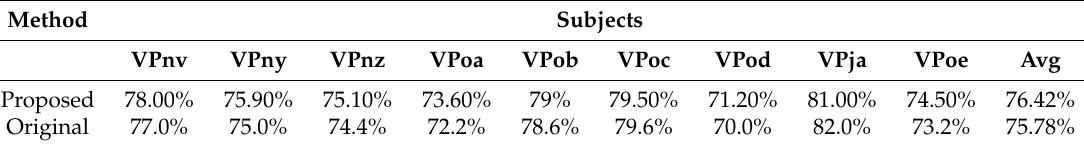
Table 2. Binary Classification Accuracy